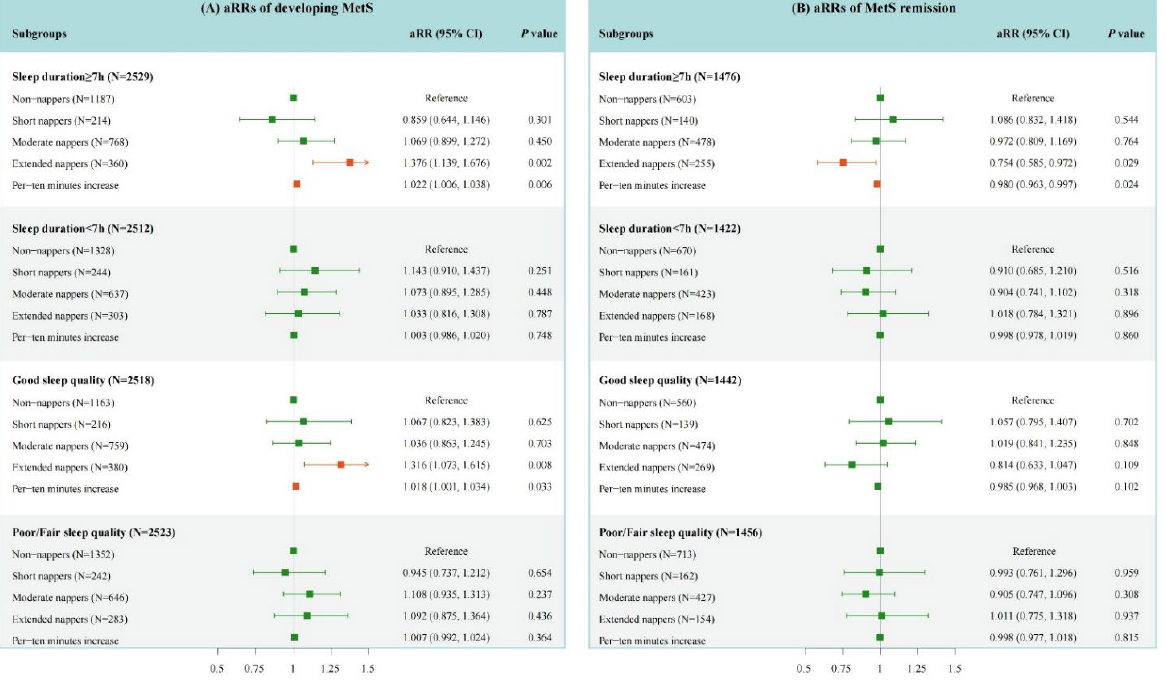
Figure 2. The association of daytime napping duration with the incidence and remission of MetS in the subgroups by night-time sleep duration and quality. Graphs show aRR and 95% CIs for the incidence of MetS ( A ), and the remission of MetS ( B ) adjusted for age, gender, living residence, marital status, educational level, smoking status, drinking status, depressive symptoms, night-time sleep quality, night-time sleep duration, SUA, LDL-C, and hsCRP. Napping duration of non-nap- pers is 0 min/day; Napping duration of shor t nappers is >0 min/day to ≤30 min/day; Napping dura- tion of moderate nappers is >30 min/day to ≤90 min/day; Napping duration of extended nappers is >90 min/day. Orange means aRR value is statistically significant; green means aRR value is not sta- tistically significant. 3.4. Association of Baseline MetS Status with Changes in Daytime Napping Duration Prior to the main analyses, GEE was performed to take into account the association of changes over the follow-up time by including a term for time and the main effect of MetS-related variables, and a term for the interaction between them in fully adjusted mod- els. However, both the term for time and interaction terms were not statistically signifi- cant. Hence, we focused only on the main effect of MetS. The results of the crude and fully adjusted GEE models are shown in Table 3. MetS significantly increased the duration of daytime napping during the subsequent follow-up period ( β : 2.745; 95% CI: 1.360–4.130). When we assessed the associations between the number of MetS components (MetS se- verity score) and napping duration, the regression coefficient increases gradually as the MetS severity score value increases. Compared with those without abnormal component of MetS, the subsequent daytime napping duration increased by 7.053 min (95% CI: 3.435– 10.670) among participants with five components of MetS. Analyses of the individual MetS components revealed that hyperglycemia, hypertriglyceridemia, hypertension, and central obesity were all significantly associated with future longer daytime napping du- ration. Central obesity shows the largest effect ( β : 2.710; 95% CI: 1.309–4.111).